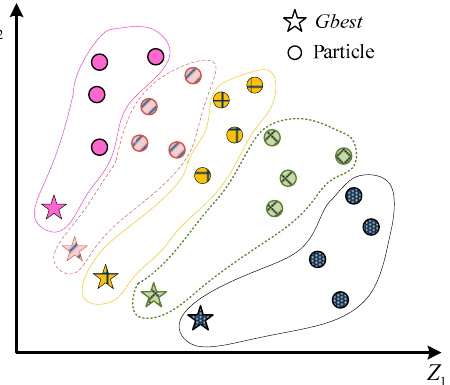
Figure 6. Illustration of global optimal guide assignment for individual particle.